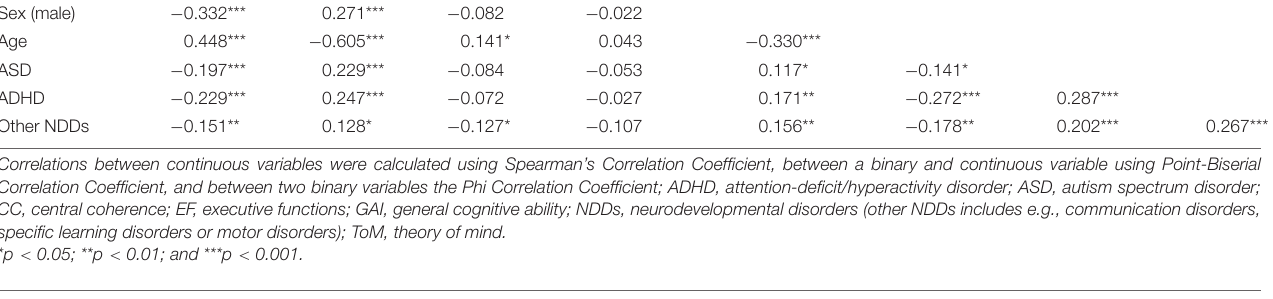
TABLE 3 | Results from the linear regressions with central coherence, executive function and IQ as predictors of Theory of Mind, measured with the Reading the Mind in the Eyes Test.